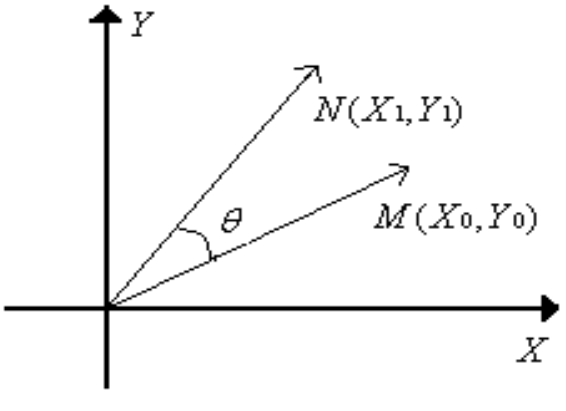
Fig. 2 the triangle spinning of